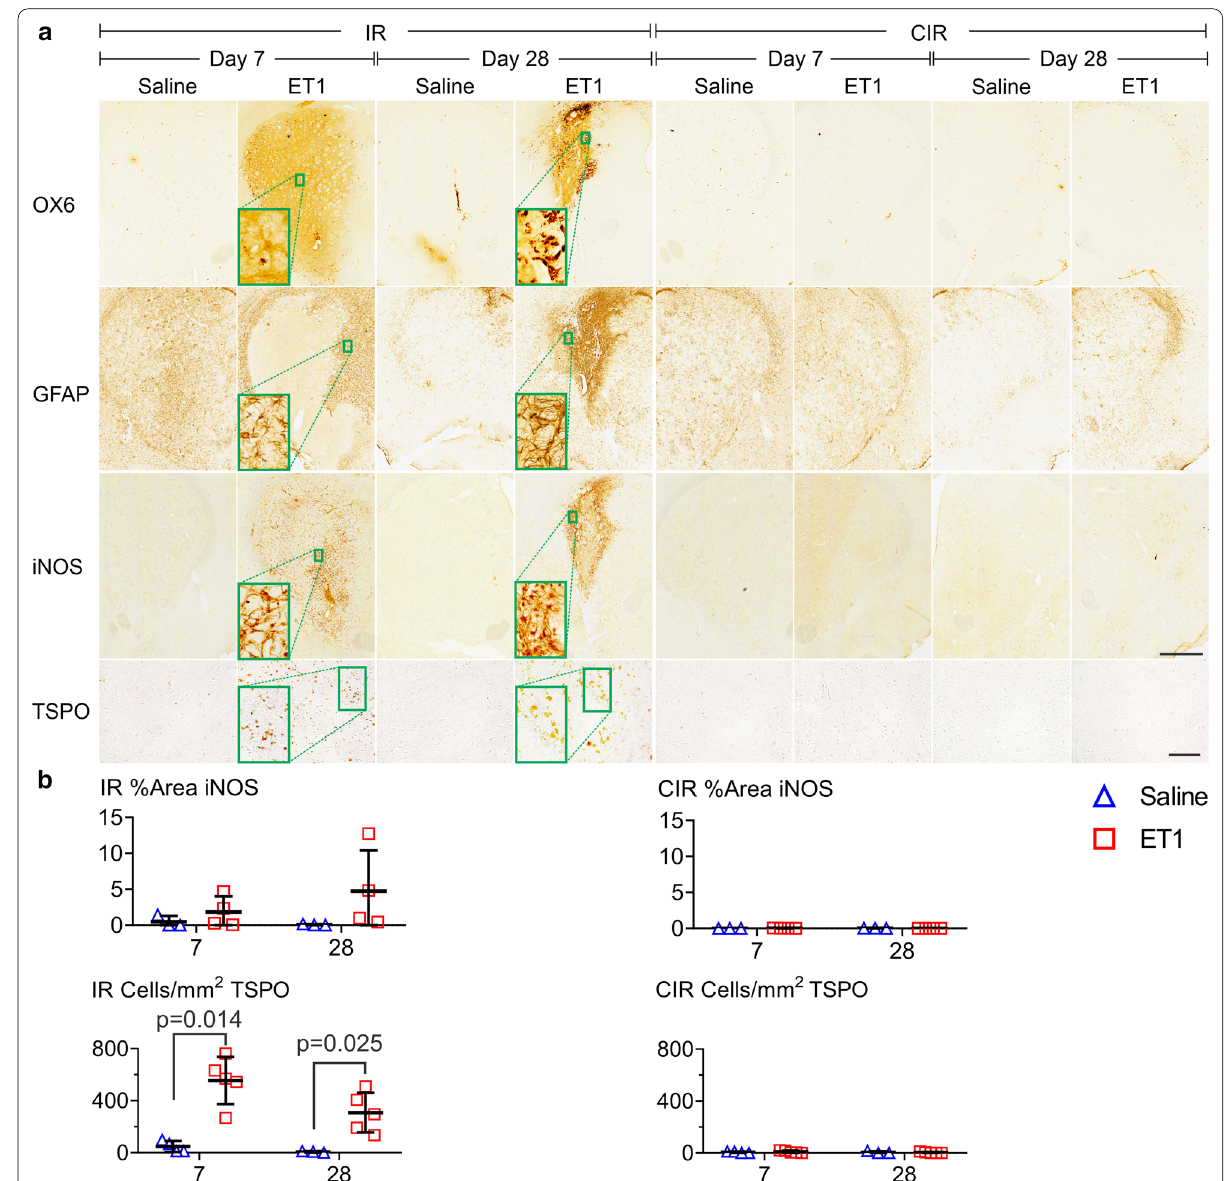
TSPO cell counts were low and unaffected by stroke (Fig. 5 and Additional file 1: Online Fig. 5). Recogniz- ing that spillover of PET signal from the infarct into the ipsilateral corpus callosum might indicate an increased uptake in [ 18 F]FEPPA PET when there is no TSPO over- expression, we used TSPO immunohistochemistry for further comparison of TSPO with GFAP, iNOS, and